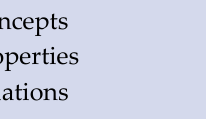
Figure 3. The main layers of the proposed ontology structure.